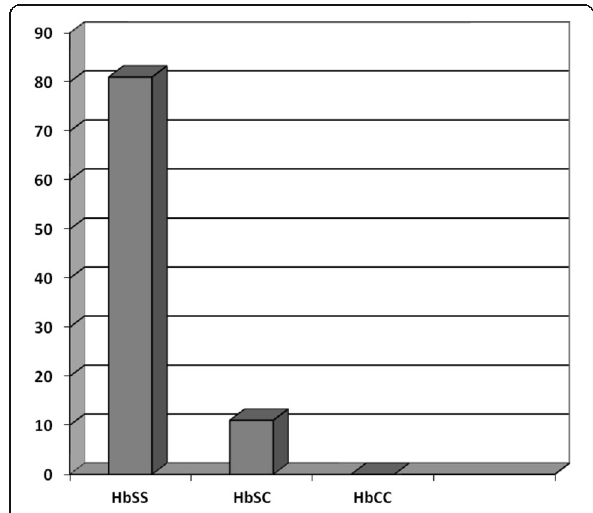
Fig. 1 Pattern of Haemoglobinopathies in the respondents with SCD